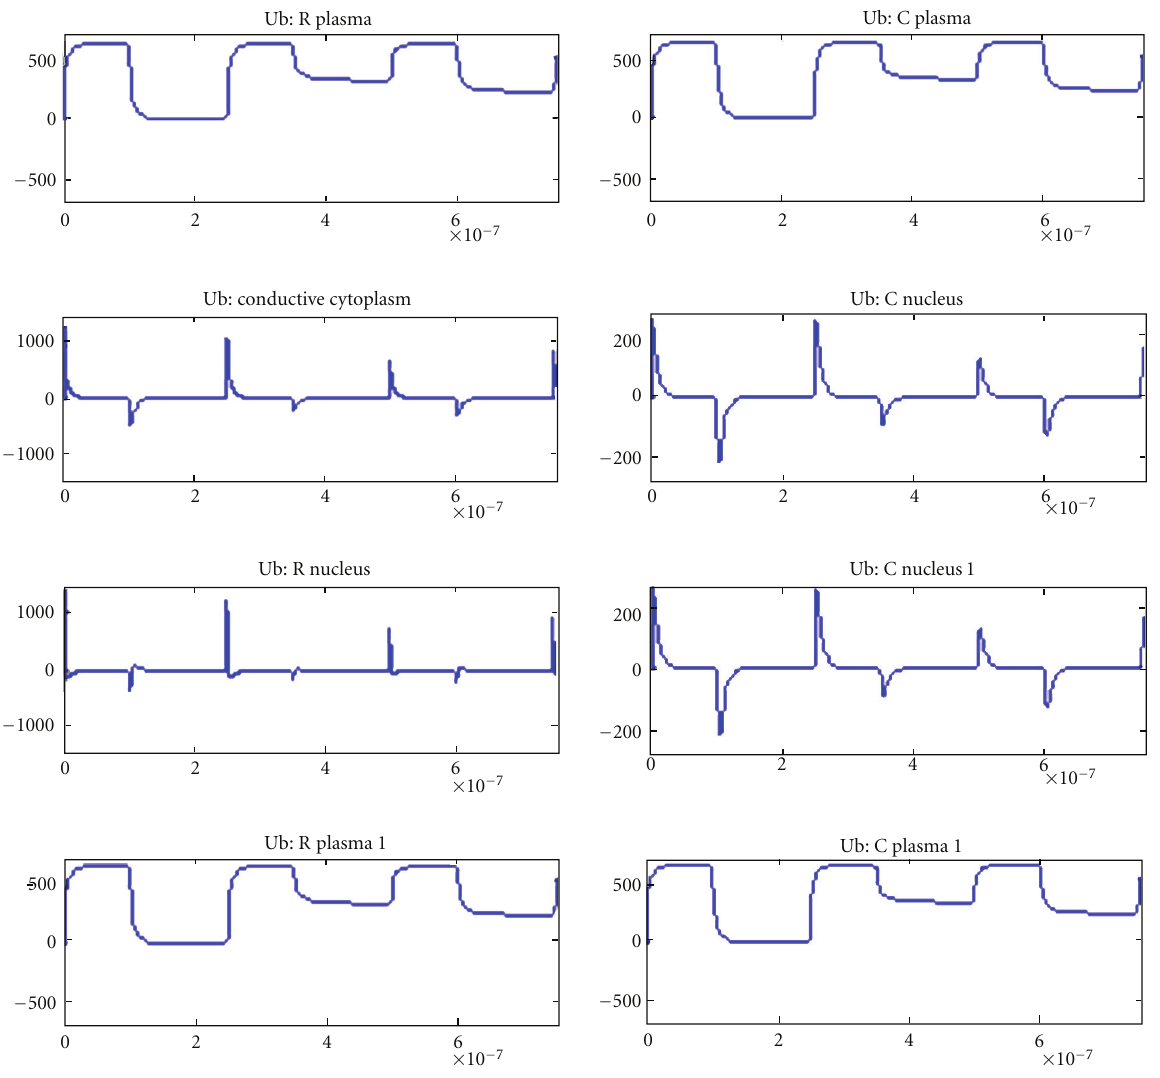
Figure 6: Voltage across various cell elements in tissue with normal and tumor cells.